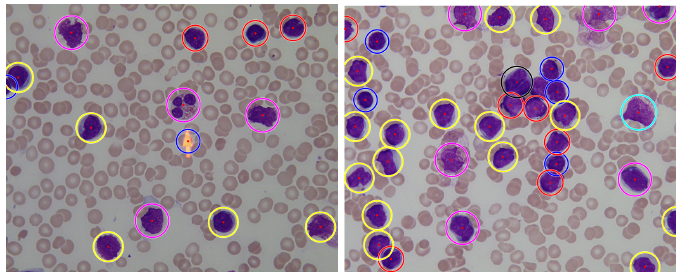
Figure 15. Example of the application with H channel values in the range [0–1]. On the left, the algorithm selects the yellow arrow as a blob, while on the right, we show a complex situation in which a WBC inside the cells agglomerate is not selected as a valid